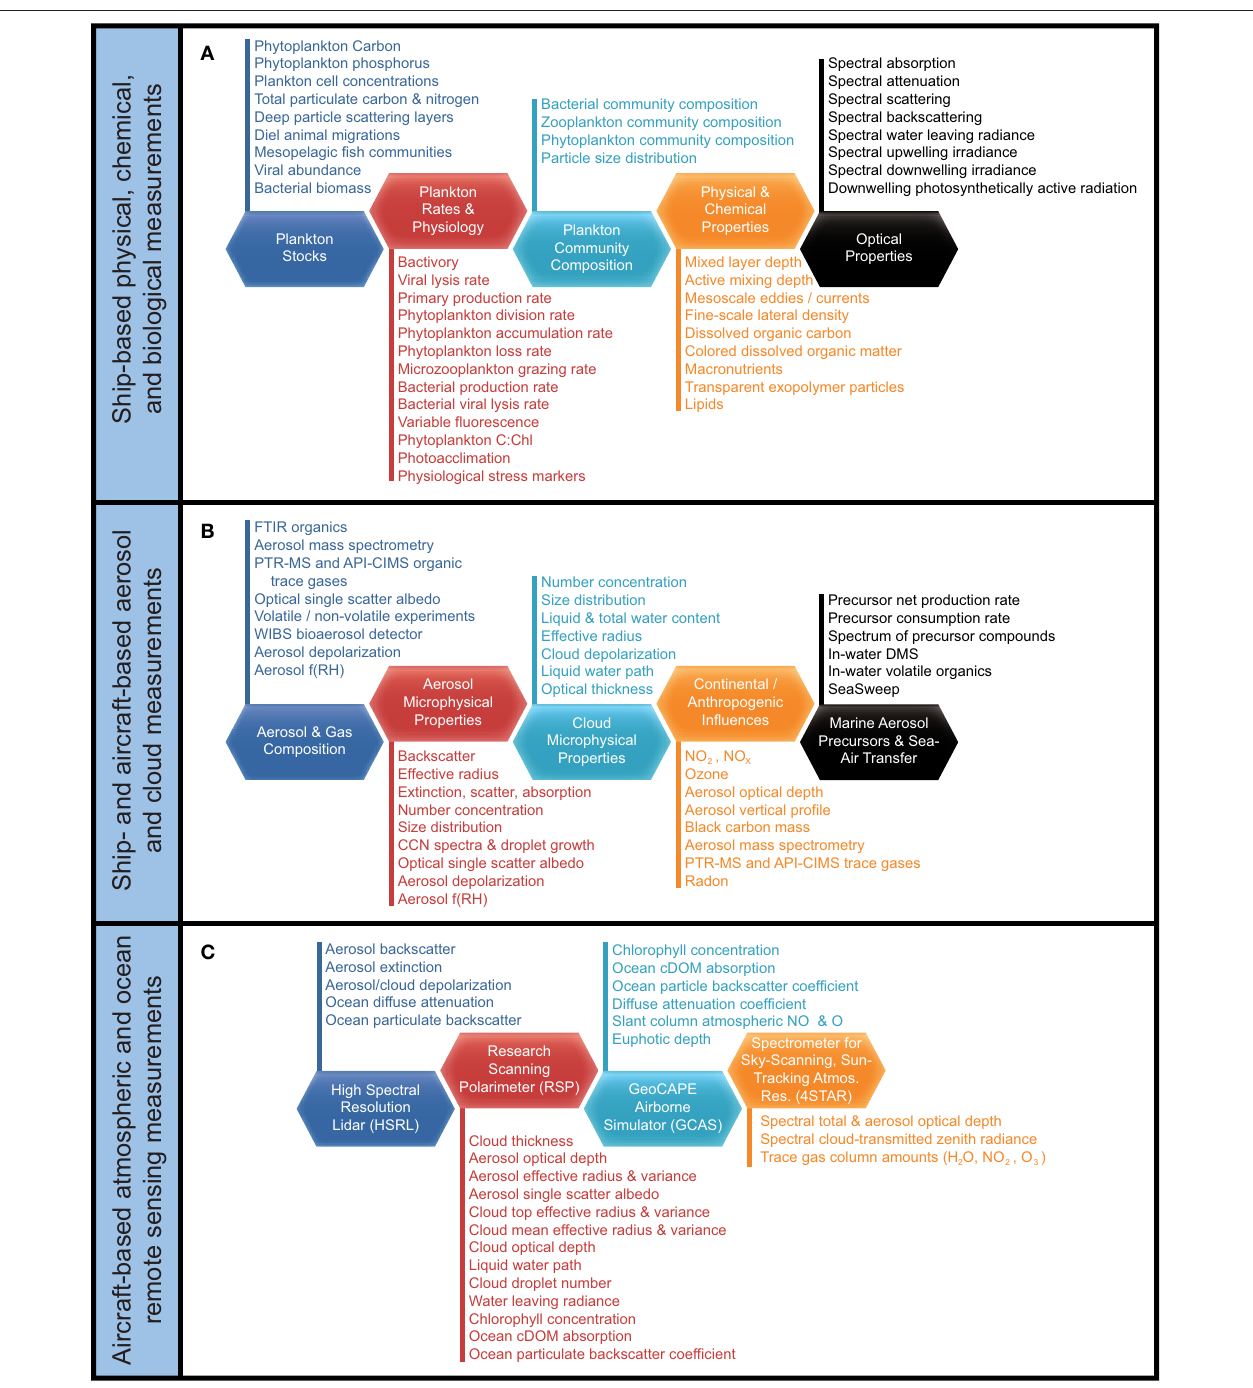
FIGURE 4 | NAAMES measurements. (A) Ship-based measurements targeting (dark blue hexagon) plankton stocks, (red hexagon) plankton rates and physiology, (light blue hexagon) plankton community composition, (orange hexagon) physical and chemical properties, and (black hexagon) optical properties. (B) Ship- and aircraft-based measurements targeting (dark blue hexagon) aerosol and gas composition, (red hexagon) aerosol microphysical properties, (light blue hexagon) cloud microphysical properties, (orange hexagon) continental and anthropogenic influences, and (black hexagon) marine aerosol precursors and genesis. (C) Aircraft-based atmospheric and ocean remote sensing measurements from (dark blue hexagon) HSRL, (red hexagon) RSP, (light blue hexagon) GCAS, and (orange hexagon) 4STAR.